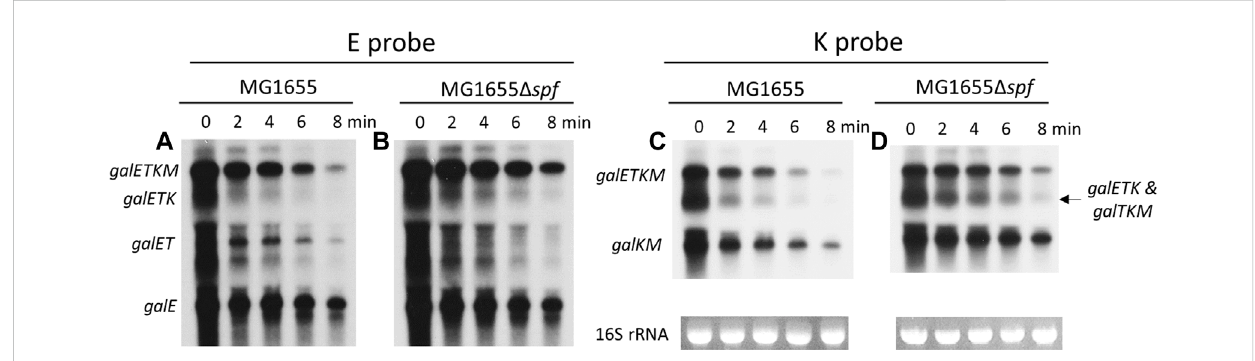
FIGURE 2 Spot 42 accelerates the mRNA decay rate of the 3 ′ end-sharing mRNA only. (A, B) Northern blots of gal mRNA from wild type (WT) MG1655 and MG1655 Δ spf in the presence of rifampicin (100 μ g/mL) with E probe. (C, D) Northern blots of gal mRNA from wild type (WT) MG1655 and MG1655 Δ spf in the presence of rifampicin (100 μ g/mL) with K probe.